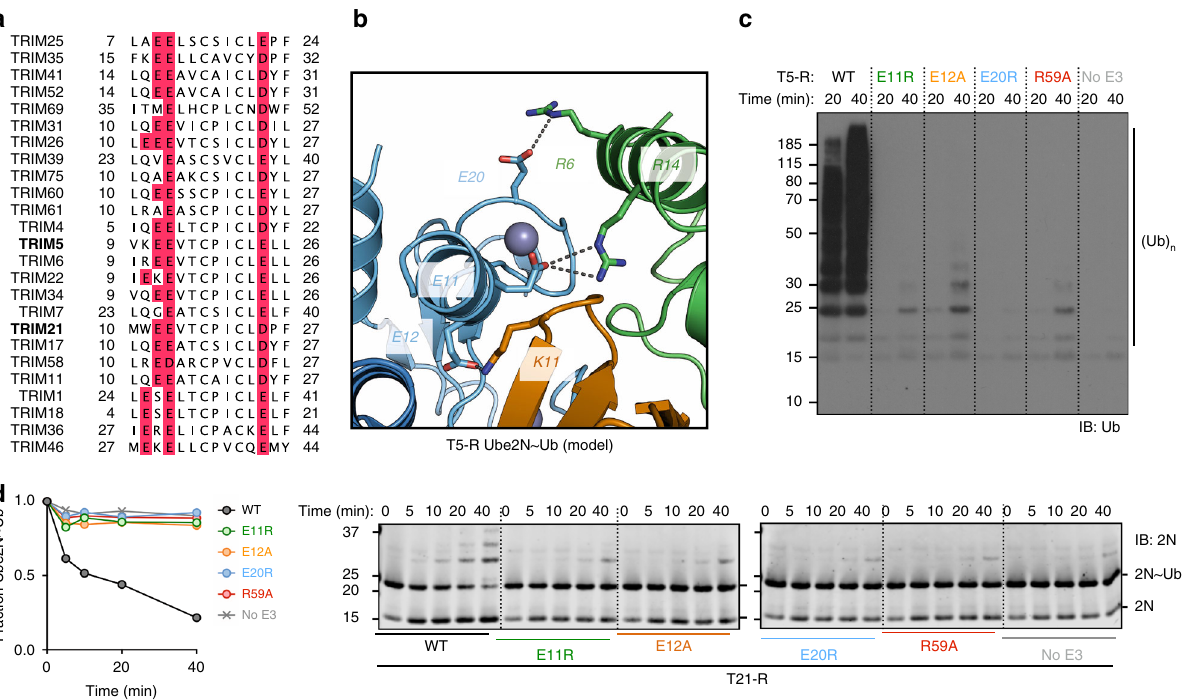
Fig. 7 The ionic anchor points are structurally and functionally conserved in TRIM 5. a Clustal omega multiple sequence alignment of TRIM proteins. Ionic anchor points are highlighted in red. The sequences of TRIM21 and TRIM5 RING domains are highly similar (sequence identity: 47.3, sequence similarity: 63.4 in pairwise sequence alignment; Supplementary Fig. 6). b Close-up of the tri-ionic motif in the structural model of TRIM5-RING Ube2N~Ub complex based on superposition of the T5-R Ube2N (4TKP) 22 and our T21-R Ube2N~Ub structure (the full model is shown in Supplementary Fig. 11b). c Catalysis of unanchored ubiquitin chains by Ube2N/Ube2V2 of T5-R mutants. d Catalysis of ubiquitin discharge from ubiquitin conjugated Ube2N/Ube2V2 of T5-R mutants. Source data are provided as a Source Data fi le